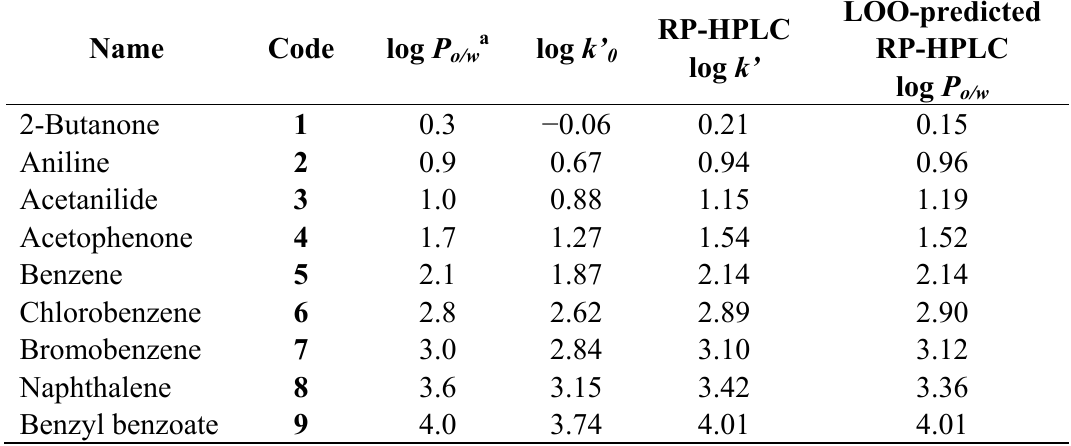
, log k’ and related RP-HPLC log P o/w 0